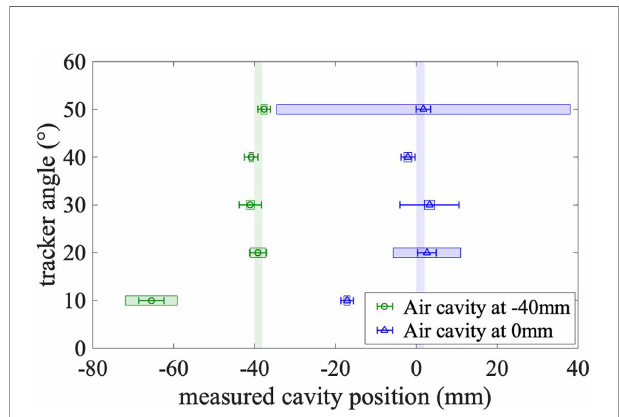
FIGURE 7 | Measured positions of the cavity for different detection angles. The measurement with an air cavity in front of the tumor volume (at -40 mm) is plotted as green circles. The blue triangles show the measurement with the cavity in the middle of the tumor volume (0 mm). The true positions of the air cavity are shown as the vertical green and blue bands. The error bars represent the statistical uncertainty. The colored boxes that are centered on the markers represent the systematic effect of the bin